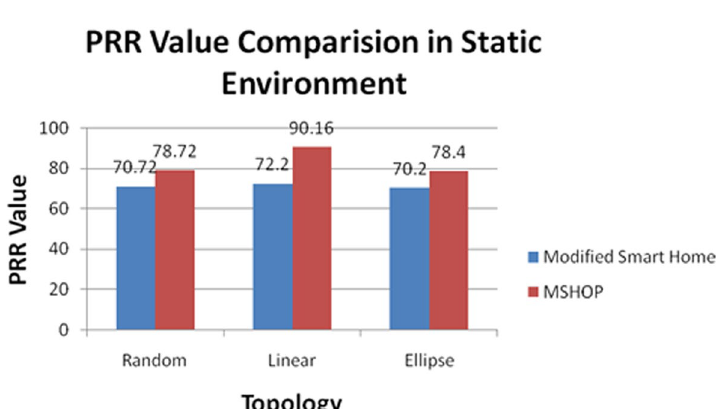
Fig. 20 PRR compared between MSH and MSHOP in static